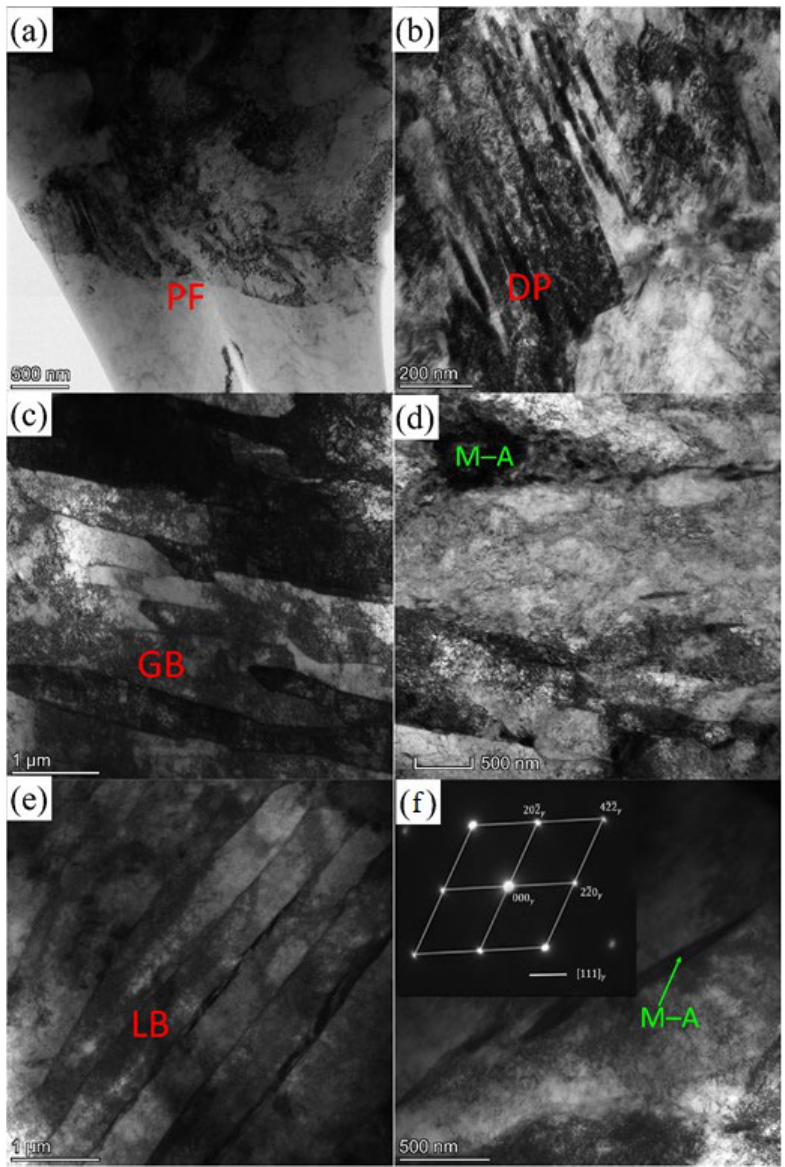
Figure 3. TEM of the X80 heavy-wall heat-induced seamless bend: ( a , b ) S1, ( c , d ) S2, and ( e , f ) S3.